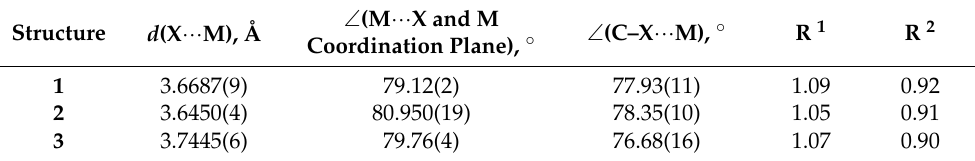
Table 4. Characteristic parameters of M ··· X semicoordination in 1 – 3 .